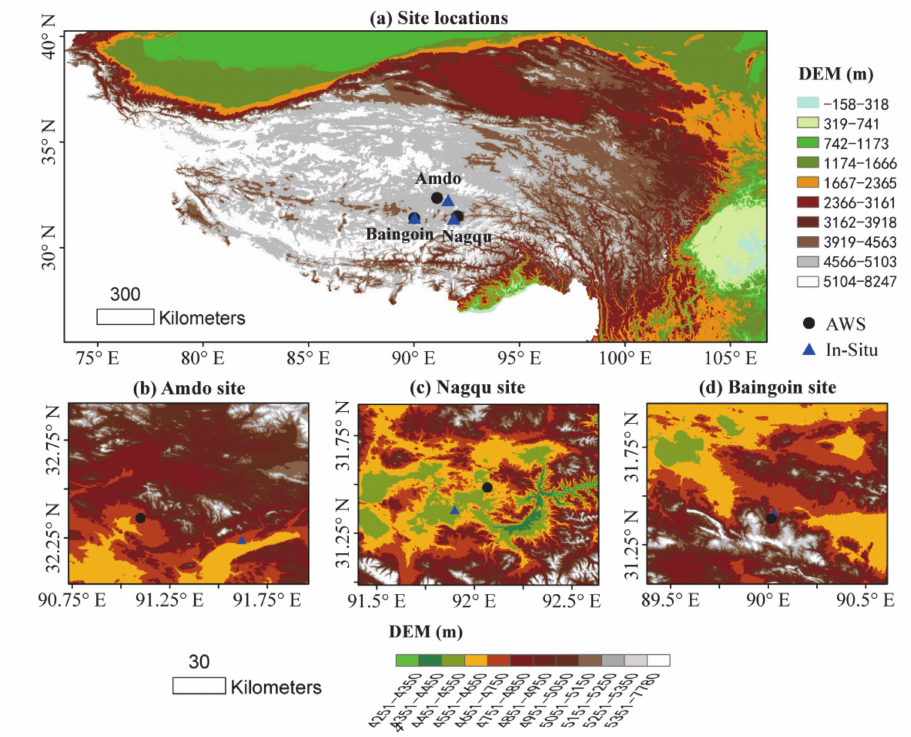
Figure 1. The locations of Ecosystem Research Stations (in situ) and AWS at the Amdo, Nagqu, and Baingoin sites. ( a ) site locations over the TP; ( b , c , and d ) locations of AWS and in situ stations for Amdo, Nagqu, and Baingoin site